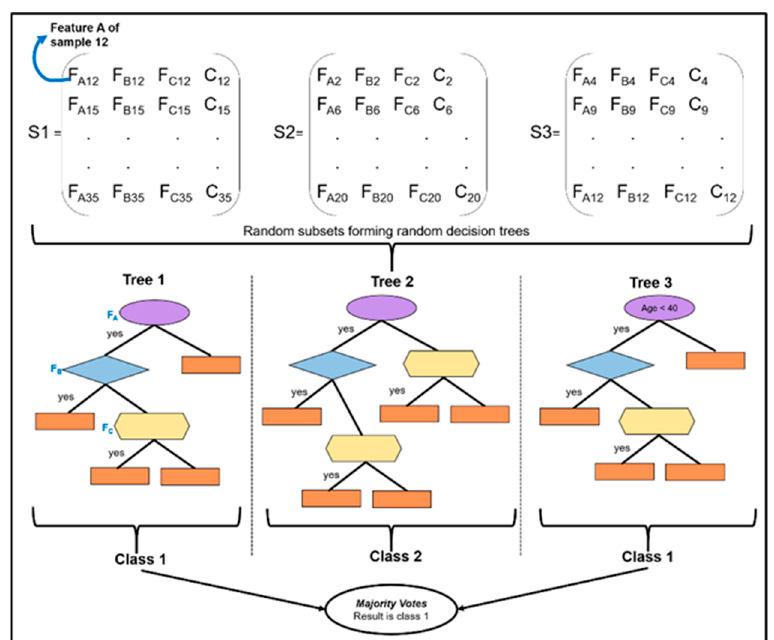
Figure 3. Random forest algorithm